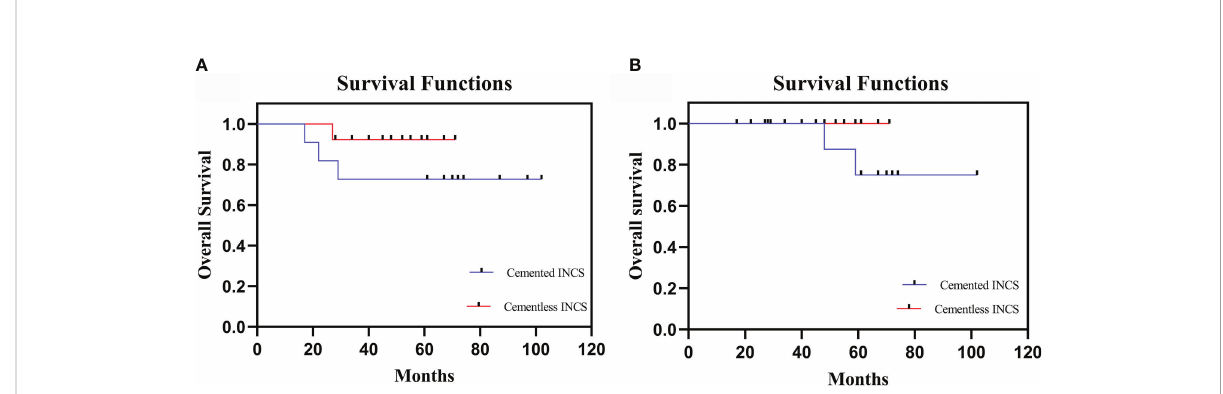
FIGURE 2 (A) The overall patient survival of HPR with cemented INCS versus cementless INCS. (B) Survival to aseptic loosening of cemented INCS versus cementless INCS. (HPR, hip-preserving reconstruction; INCS, intra-neck curved